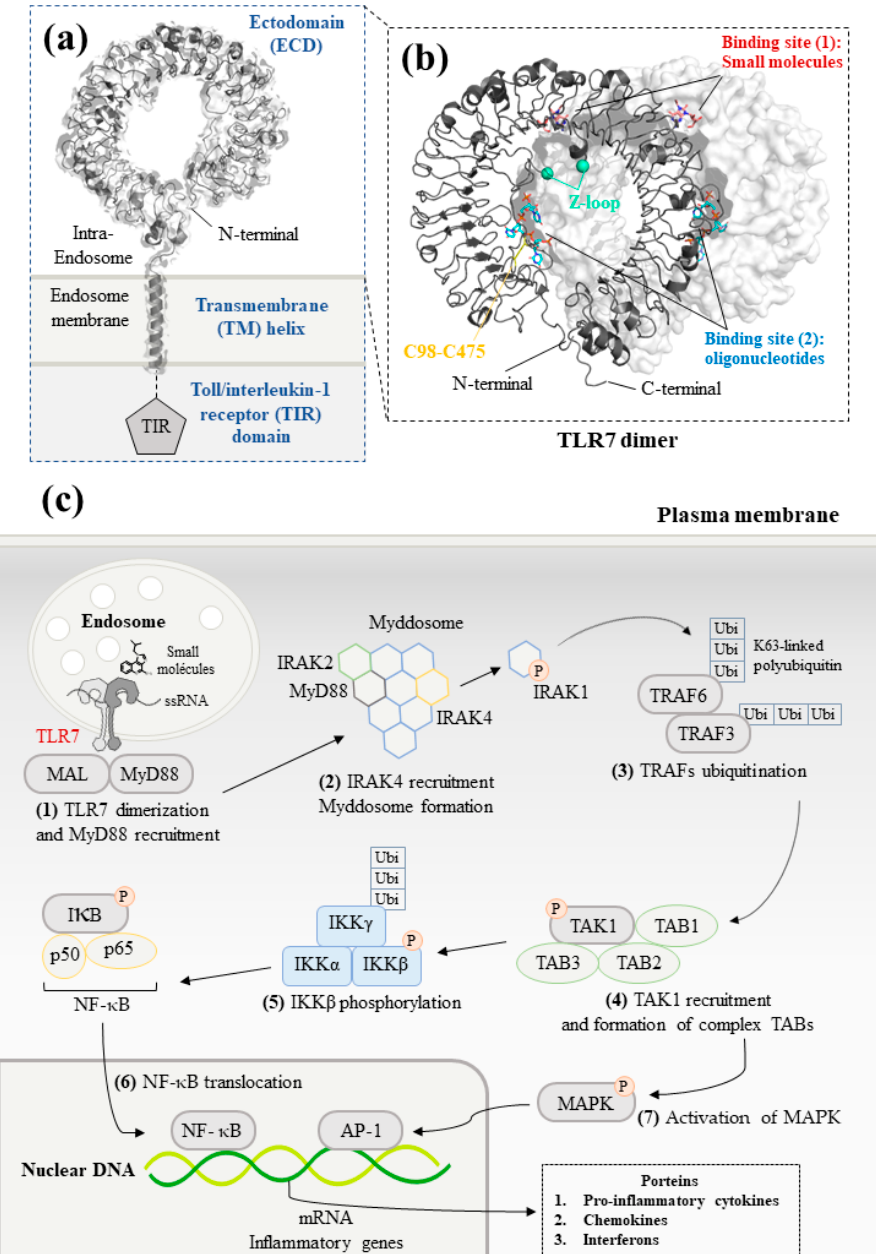
Figure 1. Structure and signaling pathways of the toll-like receptor 7 (TLR7): ( a ) Schematic representation of TLR7. The N-terminal ectodomain (ECD) locates in the endosome. The transmembrane helix consists of an α -helix across the endosomal membrane. The details of the structure of toll/interleukin-1 receptor (TIR) domain are not illustrated due to the lack of data for TLR7. Data are from reference [23] (PDB ID: 7CYN). ( b ) Front view of the ECD dimer. The cleaved Z-loop and a disulfide bridge between Cys98 and Cys475 are shown in cyan and yellow, respectively. The binding site of small molecules and synthetized oligonucleotides are illustrated in red and blue, respectively. Data are from reference [24] (PDB ID: 5GMG). ( c ) TLR7-mediated MyD88-dependent signaling pathways. Firstly, the recognition between small-molecule ligands or ssRNA and TLR7 allows to initiate downstream signaling. MyD88 then forms the myddosome with IRAK4, which phosphorylates and releases IRAK1. After that, TRAF6 is auto-ubiquitinated and activates TAK1. TAK1 forms a complex with TAB1/2/3. Finally, translocation of NF- κ B and activation of MAPK signaling pathway generates innate immune responses that lead to the production of pro-inflammatory cytokines and